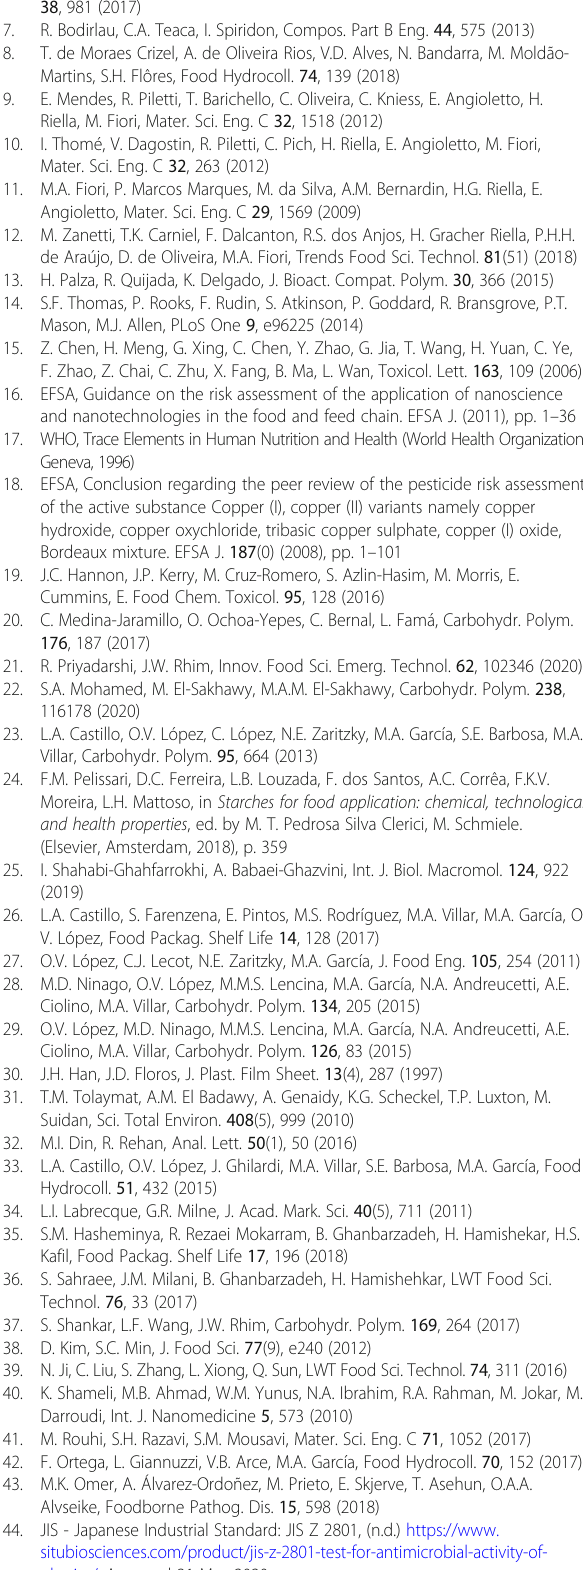
Additional file 1: Figure S1. FT-IR spectra of TPS films containing Cu and Si-Cu particles at different concentrations. Figure S2. Stress-strain curves of TPS films containing a) Cu and b) Si-Cu particles at 0,75, 1, and